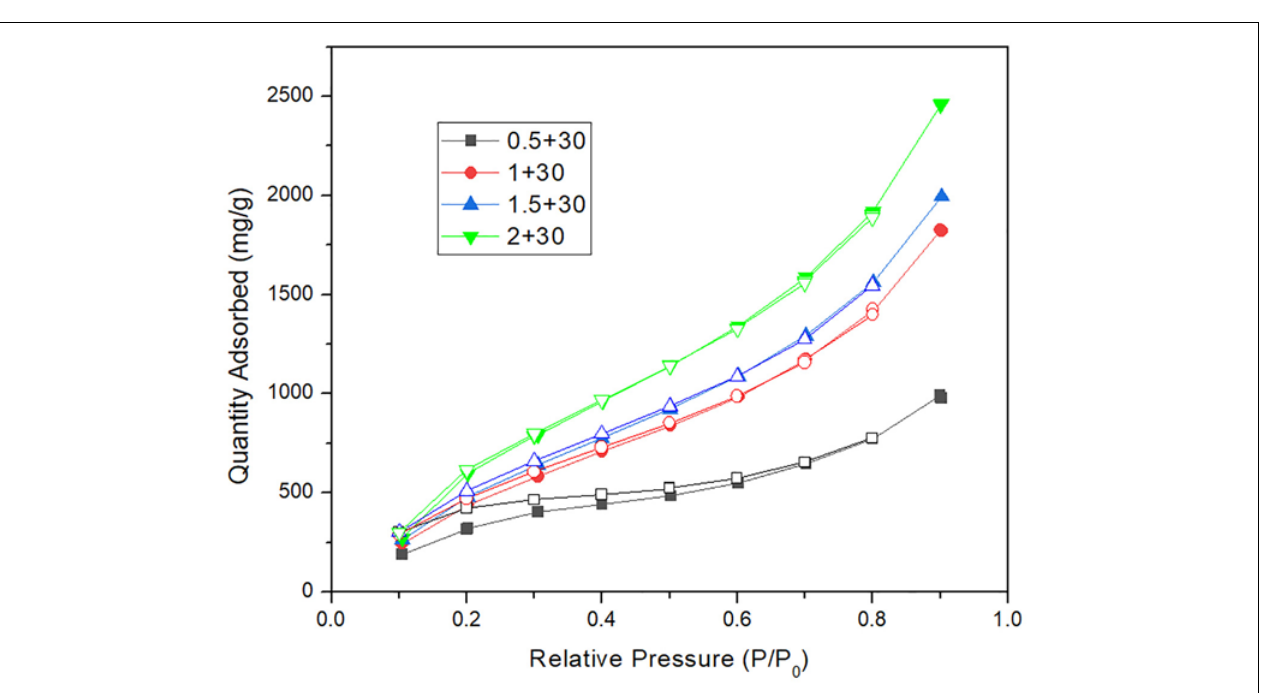
FIGURE 6 | The comparison of water adsorption isotherms between calcium chloride carbon nanotubes mil-101 (Cr) composite and mil-101 (Cr)